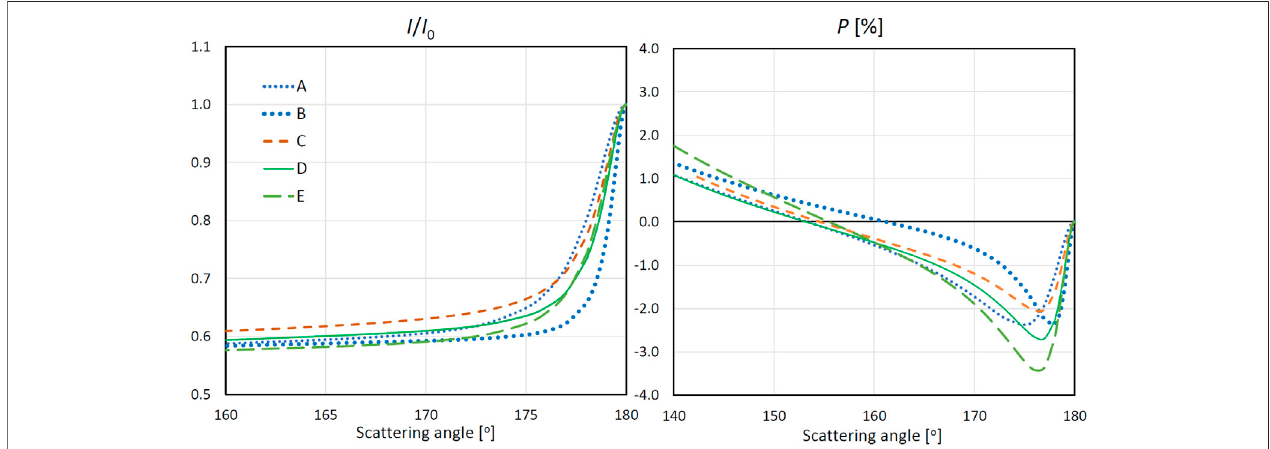
FIGURE 4 | The normalized intensity I / I 0 and the degree of linear polarization P of light re fl ected by a discrete random medium in dependence on the scattering angle, which were obtained with models A − E and ξ = 20%. The values of x and m are speci fi ed in the text.